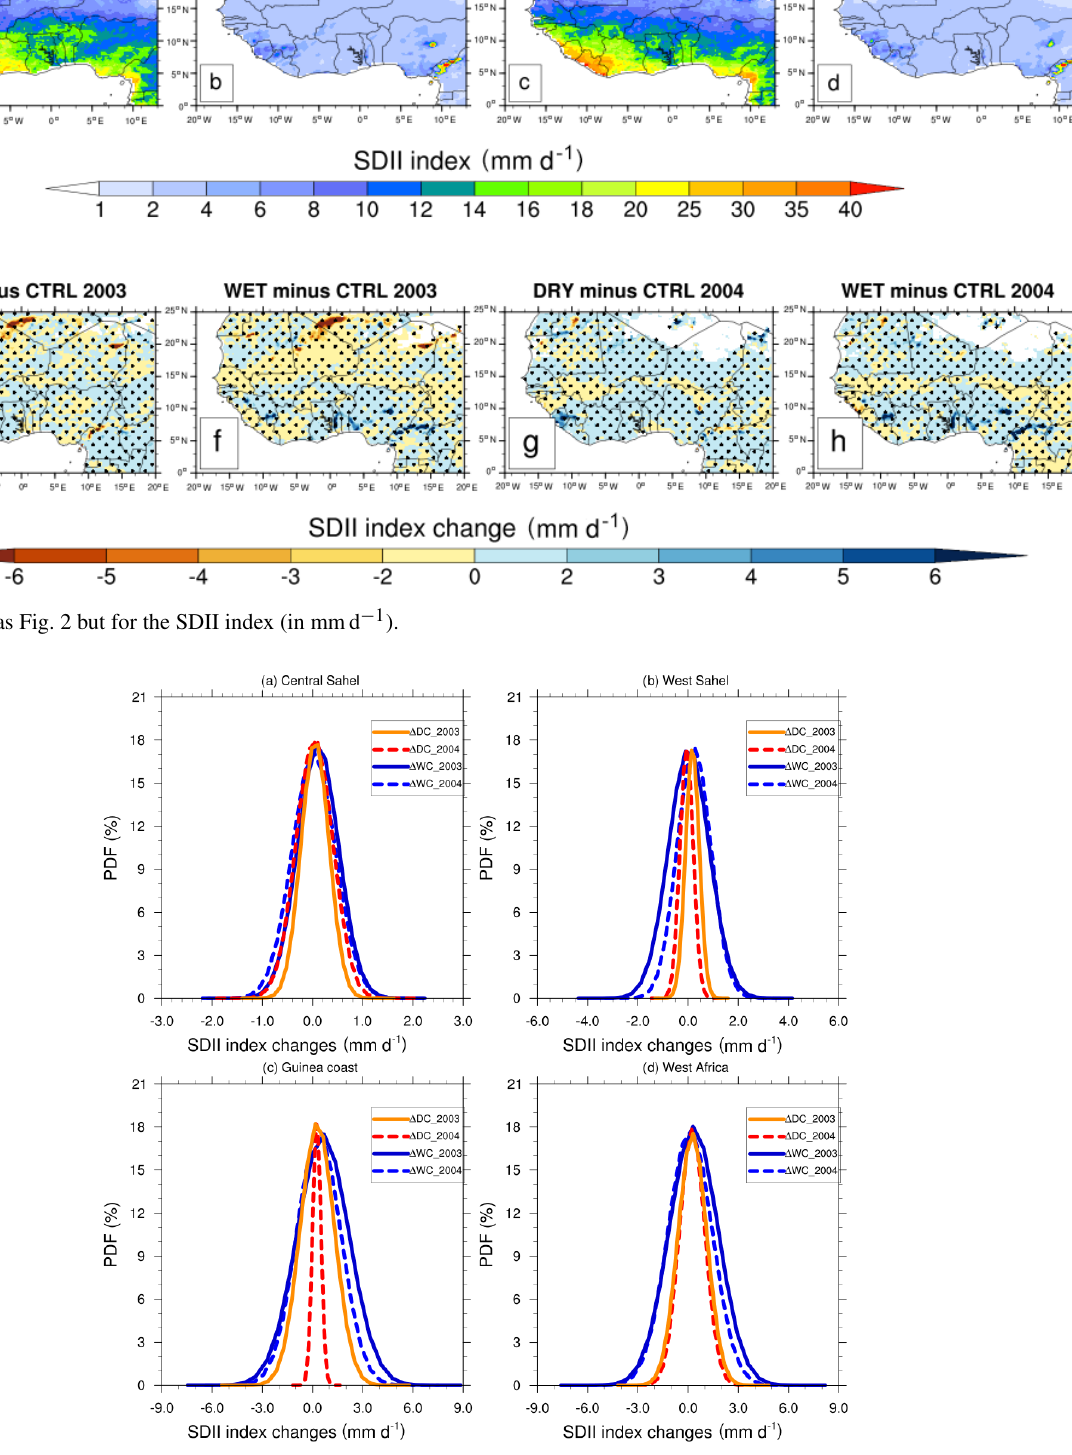
Figure 5. Same as Fig. 3 but for the SDII index (in mmd − 1 ).